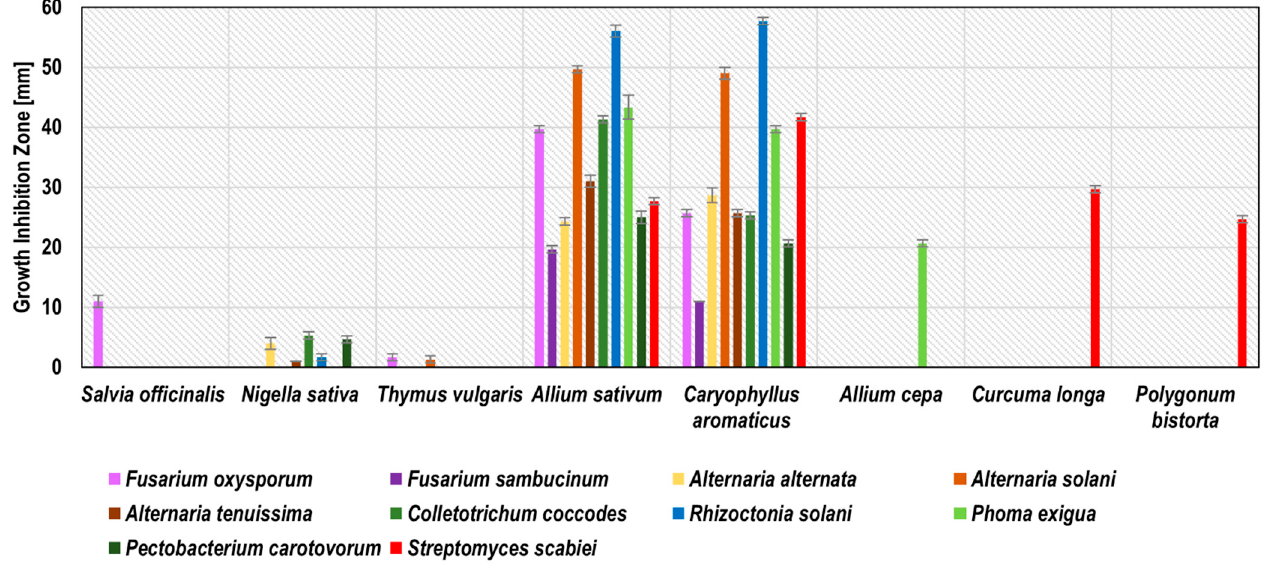
Figure 1. Activity of plant water extracts against potato seed phytopathogens measured as growth inhibition zones in the agar-well diffusion method. The graph only includes plants that showed inhibition of at least one phytopathogen.